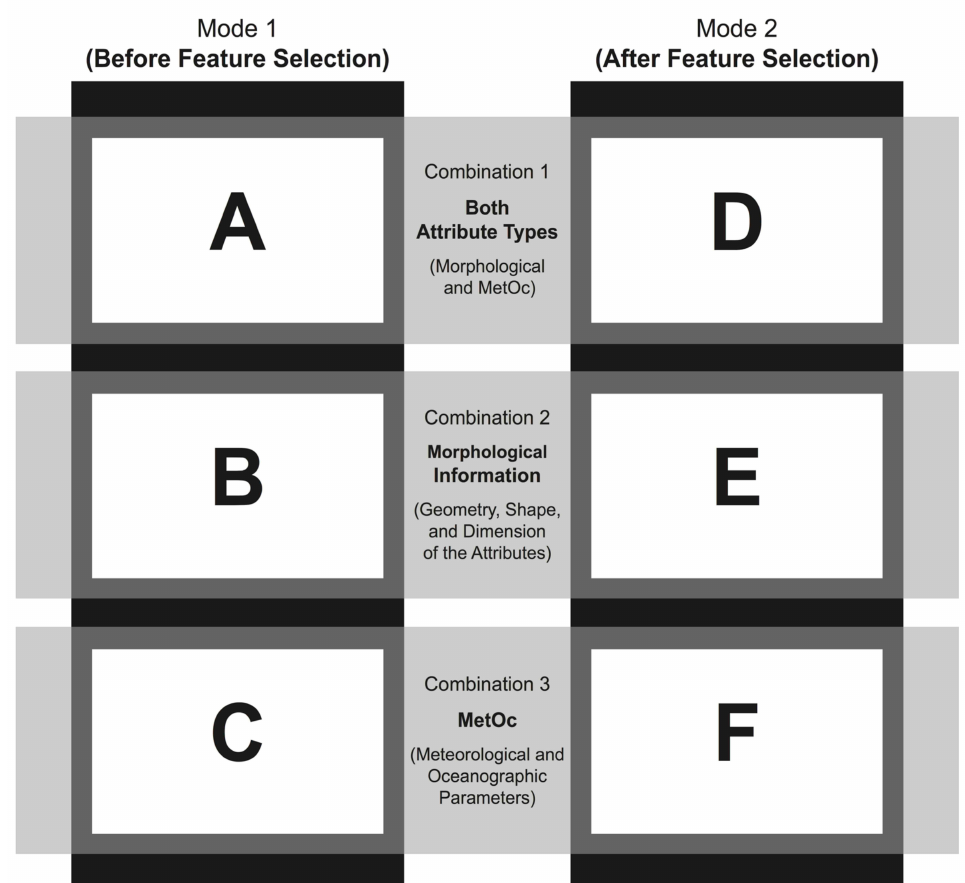
Figure 2. Schematic displaying the three levels in which the 36 machine-learning (ML) classification algorithms were compared: (i) Primary comparison level: The six techniques were compared among themselves six times using the same set of attributes in each of the six white boxes; (ii) Secondary comparison level: Each technique was compared using different sets of attributes three times before, and three times after feature selection—two vertical black boxes; and (iii) Tertiary comparison level: Every technique was compared using different sets of attributes two times per combination of variables—three horizontal gray boxes. A, B, C, D, E, and F refer to the six variable sets. See Section